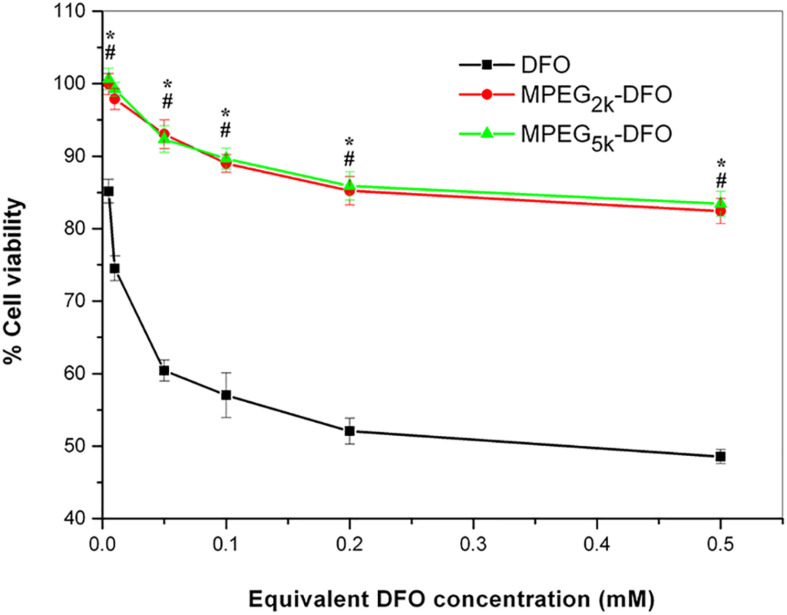
Cell viability of HUVECs in the presence of the PEGylated DFO. “*”: DFO vs. MPEG2K-DFO, P < 0.05; “#”: DFO vs. MPEG5K-DFO, P < 0.05.